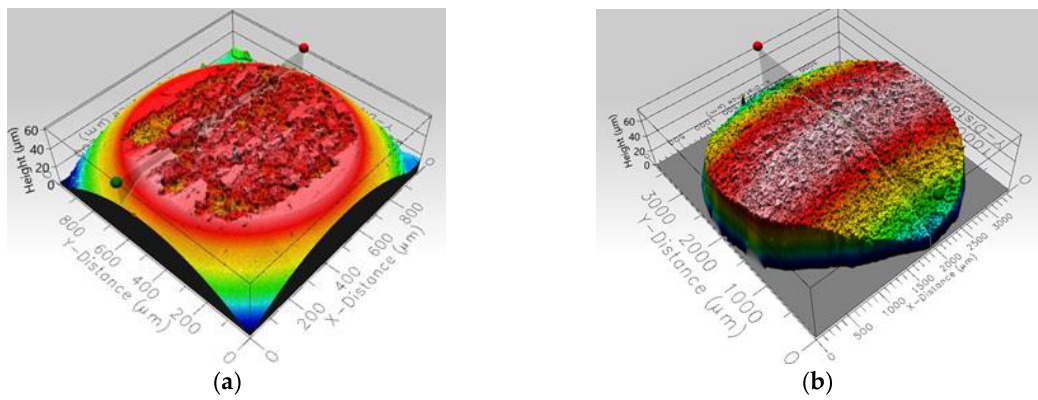
Figure 2. Profilometer characteristics of the worn ATZ sample surface used for volumetric characteristics of the mass loss during the tribological test; collected at 20 °C ( a ) and at 300 °C ( b ).